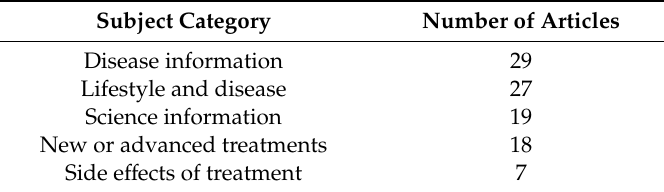
Table 5. Numbers of articles with top 100 AASs according to subject